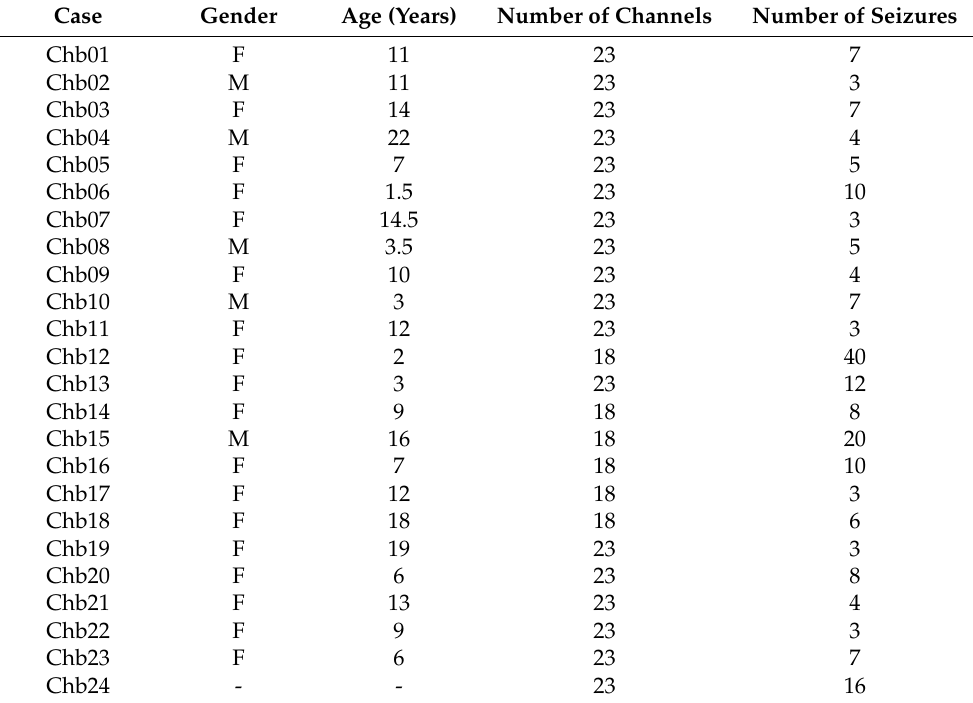
Table 1. Details of the CHB-MIT 1